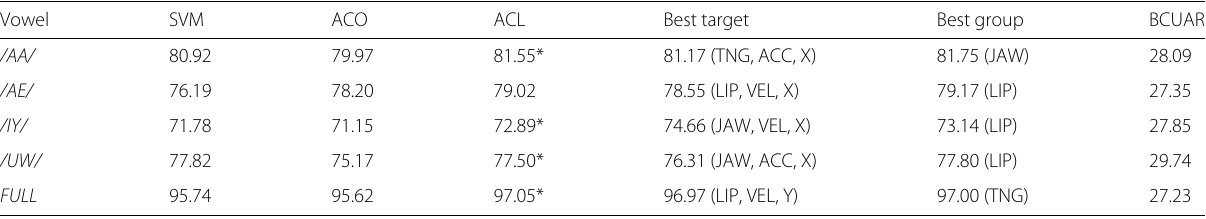
The UAR is expressed in percentage. The columns of the table represent results from several models: support vector machine (SVM), acoustic-only model (ACO), articulation constrained learning (ACL), best target using ACL, best group of targets using ACL, and the by-chance unweighted average recall (BCUAR). *Statistically significant improvement ( p < 0.05) over compared